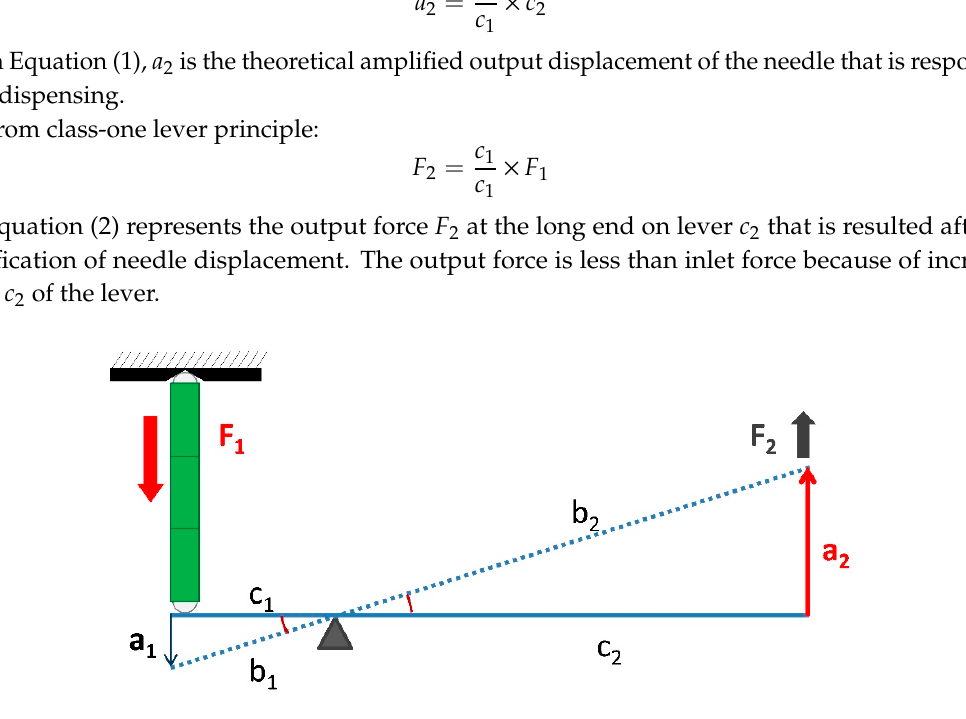
Figure 1. Schematic representation of the core mechanism for the class-one lever.